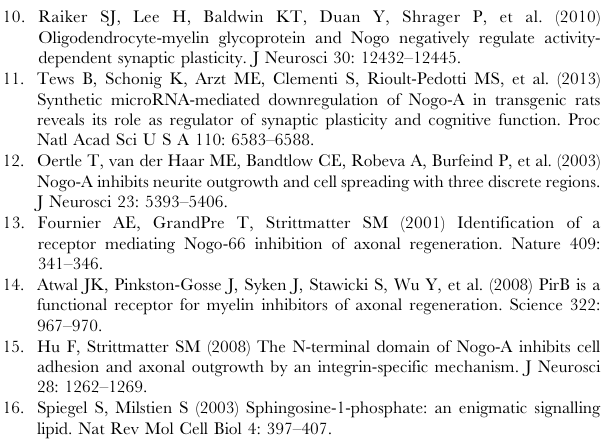
cortex (compare to Figure 1E and 1F) shows abolished S1PR2 detection using the same peptide competition assay. (TIF) Figure S3 Blockade of S1PR1, 3, 4, and/or 5 has no effect on Nogo-A- D 20-mediated cell spreading inhibi- tion. (A) 3T3 fibroblasts were plated on different concentrations of a Nogo-A- D 20 substrate in the presence of increasing concentrations of JTE-013 versus vehicle (DMSO). (B) 3T3 fibroblasts were plated on a Nogo-A- D 20 substrate in the presence of the following pharmacological inhibitors: W146 for S1PR1, VPC-23019 for S1PR1 and 3, and FTY-720 for S1PR1, 3, 4, and 5. DMSO was used as control. A function-blocking anti-S1PR5 antibody had no effect on Nogo-A- D 20-induced inhibition when compared to anti-BrdU control. (C) 3T3 fibroblasts were plated on a Nogo-A- D 20 substrate in the presence of JTE-013 in different combinations with VPC-23019, W146 and/or anti-S1PR5. DMSO was used as control. Data shown are means 6 SEM Figure S4 Knockdown efficacy of S1PR2, G q , G 12 , G 13 , and LARG. (A) Quantitative RT-PCR analysis of S1PR2 expression in 3T3 cells stably expressing S1pr2 shRNA (sh- S1pr2 ) versus control vector (sh-Vec) revealed an , 93% knockdown. (B) FACS analysis of S1PR2 expression in 3T3 cells stably expressing sh- S1pr2 or sh-Vec using the Ab14533.1 antibody. (C) Quantita- tive RT-PCR analysis of 3T3 cells treated with siRNA targeting G q , G 12 , G 13 , or Larg for 72 h. Scrambled siRNA (ctrl) was used as control. Relative quantification of knockdown efficacy: G 12 ( , 77%), G 13 ( , 78%), G q ( , 79%), and Larg (83%). (D) FACS analysis of G 13 expression in G 13 versus ctrl siRNA-treated 3T3 cells. (E) Quantitative RT-PCR analysis of E19 rat cortical neurons treated at DIV4 with siRNA targeting G 12 or G 13 for 72 h. Scrambled siRNA (ctrl) was used as control. Relative quantifica- tion of knock-down efficacy: G 12 (39%), G 13 (42%). (F) FACS analysis of G 13 expression in G 13 versus ctrl siRNA-treated E19 cortical neurons. (G) FACS analysis of LARG expression in Larg versus ctrl siRNA-treated 3T3 cells. Histograms from one representative experiment are shown. Data shown are means 6 SEM ( n = 3 experiments). (TIF)